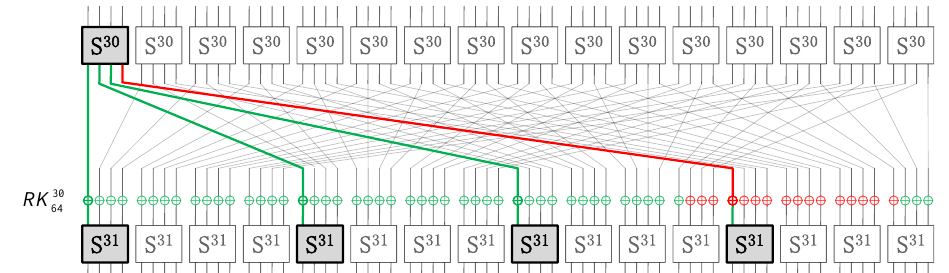
Figure 7: Part of the last two rounds of PRESENT. The relation between SO 30 are highlighted, and the determined/undetermined bits are colored green/red